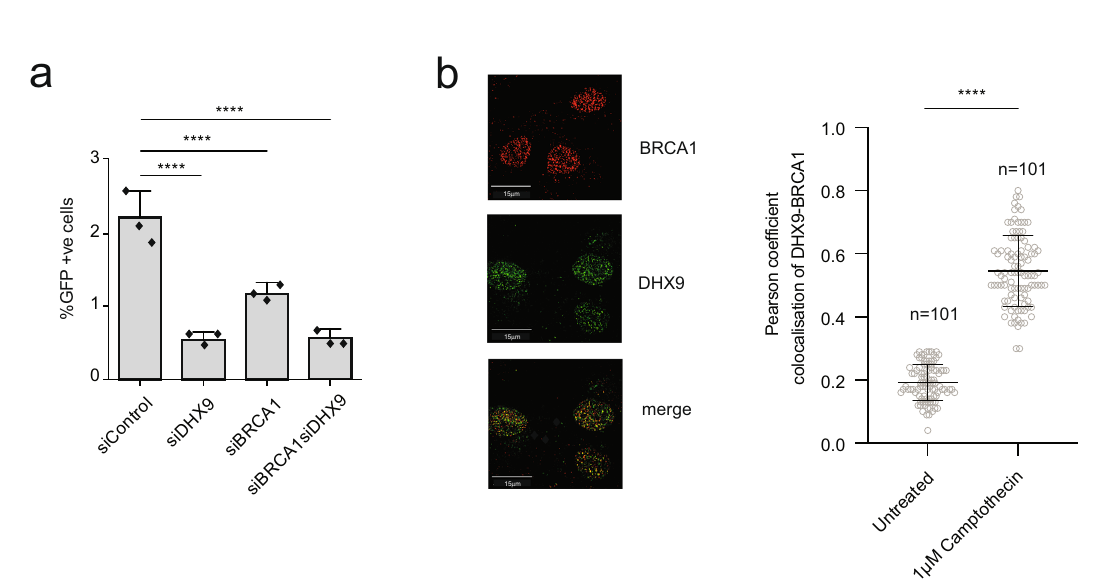
Fig. 5 DHX9 is required for the recruitment of RAD51. a Fluorescent image (left panel) and quanti fi cation (right panel) showing the decreased formation of RAD51 foci in control U2OS cells (red) and cells knocked down for DHX9 (blue) treated with 1 μ M camptothecin for 2 h then left for 2 h to recover. b DHX9 is in a common genetic pathway for the formation of RPA foci with CTIP and MRE11. RPA foci in cells knocked down using siRNA for the indicated genes are shown. Cells were treated with 1 μ M camptothecin for 2 h. c Recruitment of DHX9 to foci is dependent on ATM and ATR. Wild-type cells were inhibited for ATR and ATM using VE-821 and KU55933, respectively. d , e DHX9 is in a common genetic pathway for the formation of RPA foci with ATR and ATM. RPA foci are shown for cells treated with inhibitors for ATR (VE-821) and ATM (KU55933) ( d ) or knocked down with siRNA against ATM and ATR ( e ). f Western blot showing that knockdown of DHX9 impairs Cpt induced autophosphorylation of ATR on Thr1989 and phosphorylation of Chk1 on ser 345. Quanti fi cation of n cells (as indicated) from three pooled biologically independent experiments were performed in ( a – e ). Means of data sets were shown to be signi fi cantly different using one-way ANOVA with Tukey ’ s post hoc test. (ns not signi fi cant, * p < 0.1, ** p < 0.01, *** p < 0.001, and **** p < 0.0001). Error bars indicating one standard deviation are also indicated. Source data are provided as a Source Data fi le.